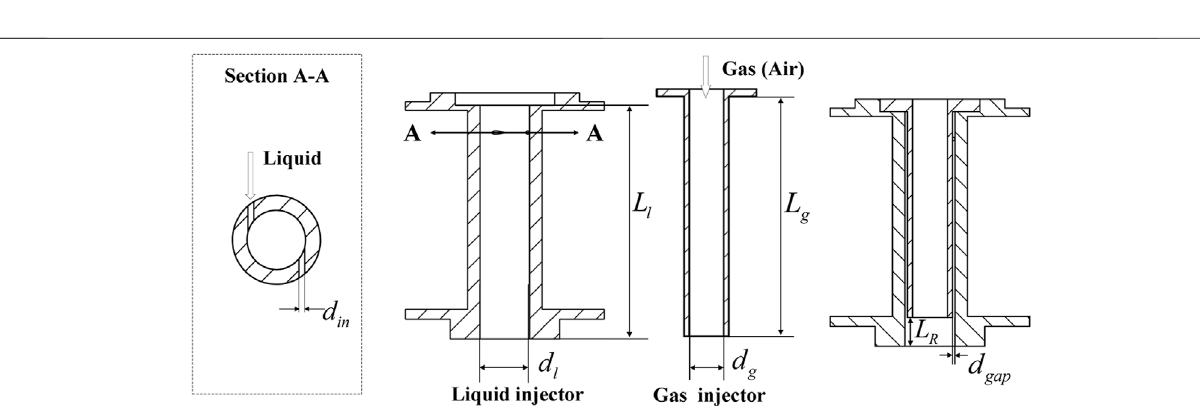
FIGURE 2 | Schematic of coaxial injectors.